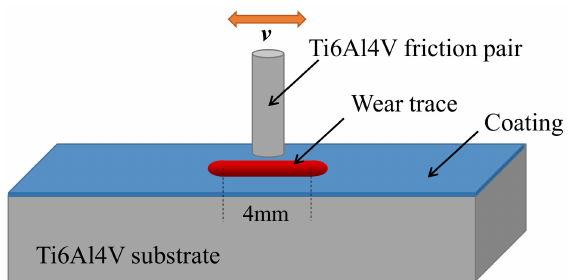
Figure 1. Friction test